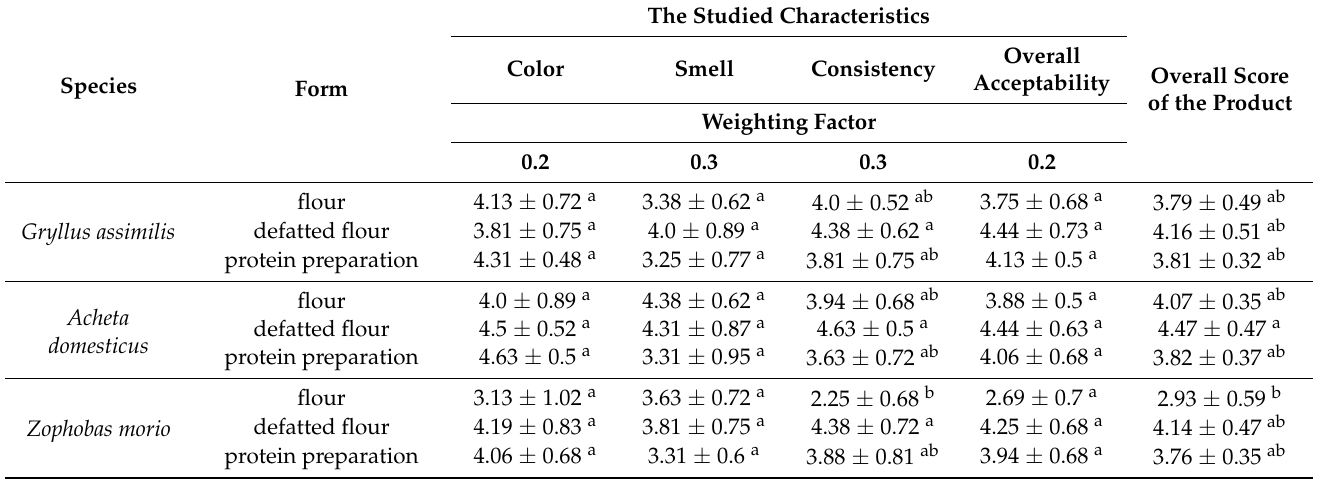
Table 2. Sensory analysis of edible insect flours and protein preparations thereof. Different letters in the same column indicate a significant difference ( p <